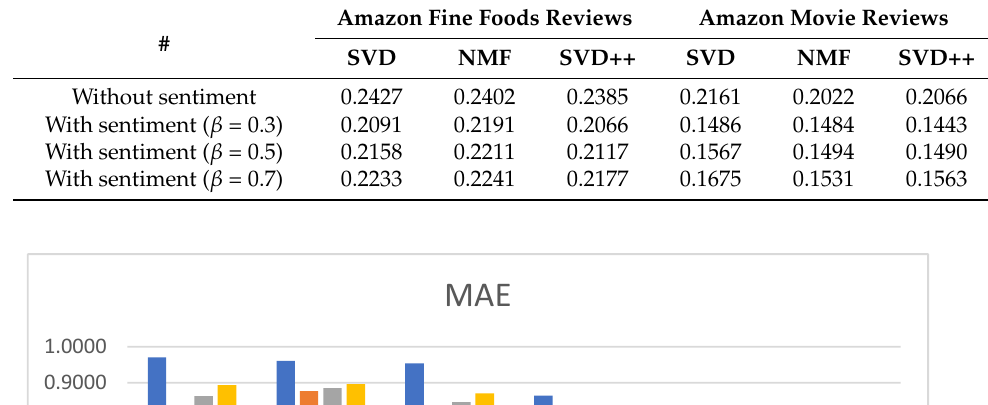
Table 5. NMAE values without and with L-CNN sentiment analysis model. Table 3. MAE values without and with L-CNN sentiment analysis model.